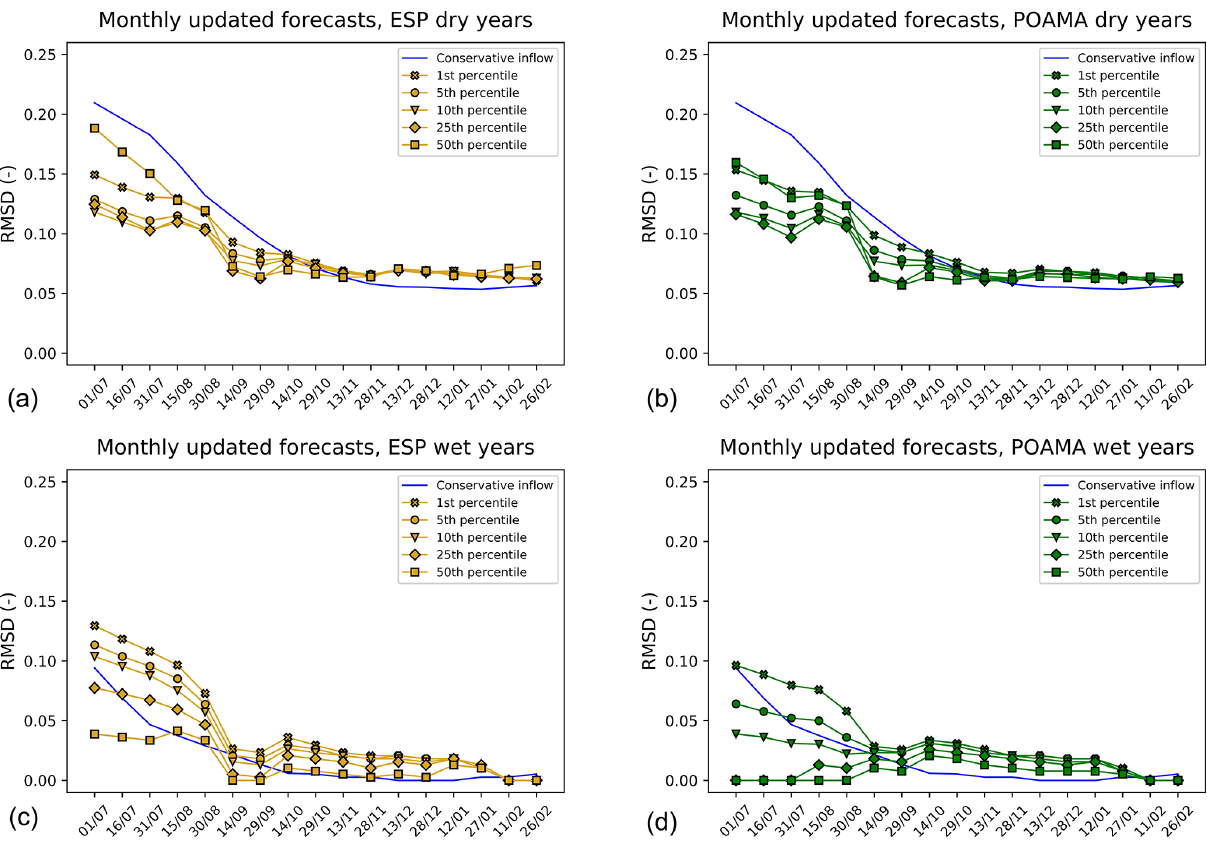
Figure 12. RMSD for all dry years (a, b) and wet years (c, d) using new inflow predictions every month from ESP (a, c) and POAMA (b, d)